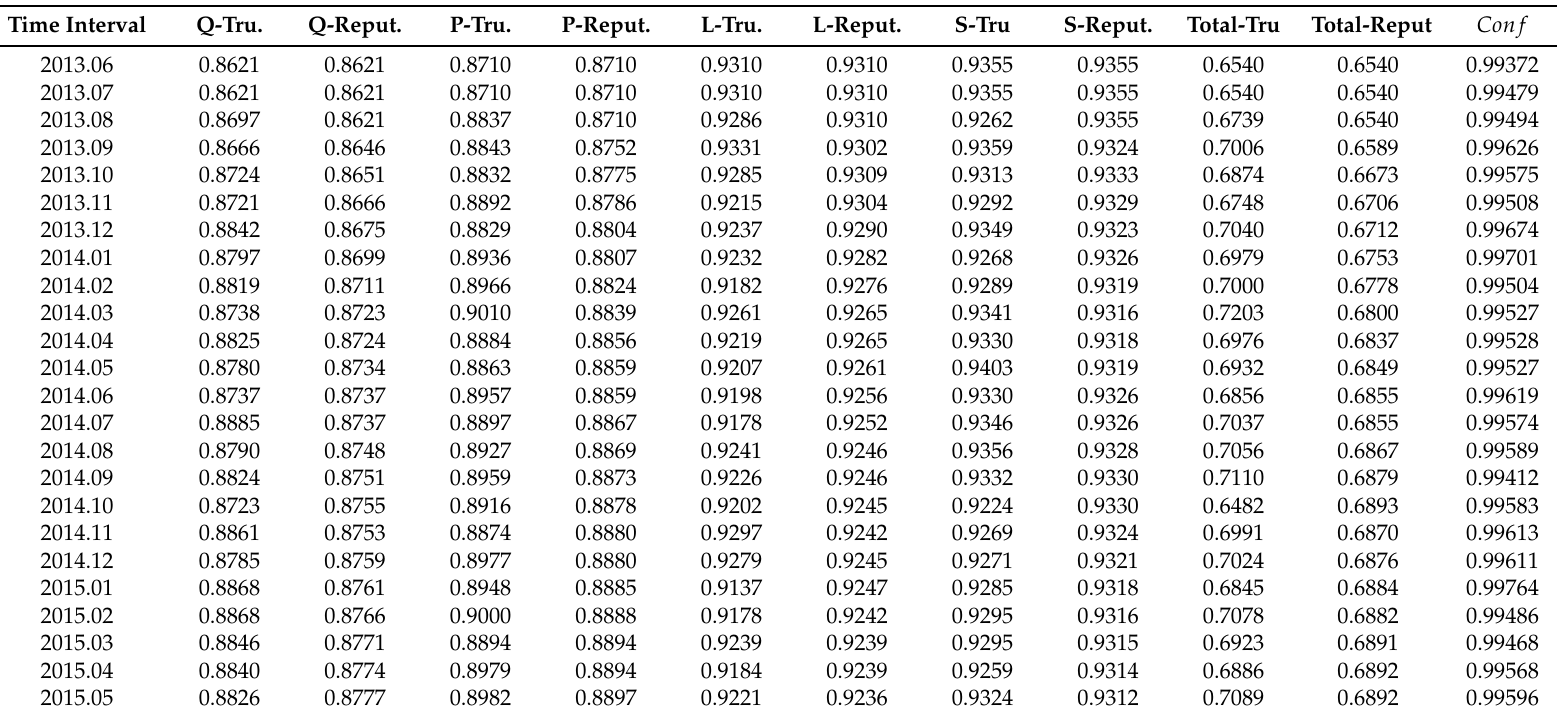
Table 7. Computational results of reputation and trust for books on Amazon over 24